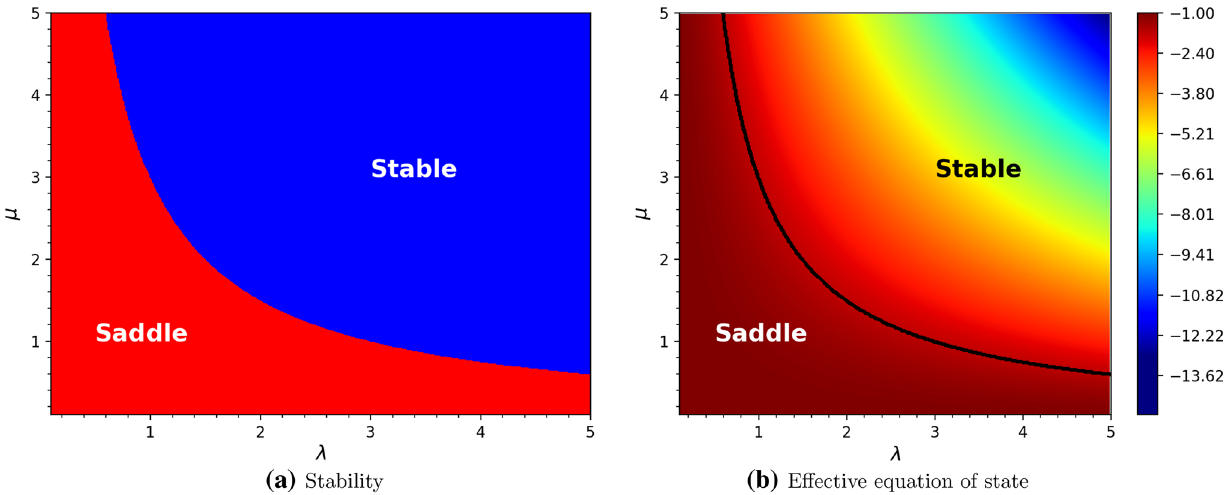
Fig. 4 On the left panel, the graph a shows the stability of the F ( B ) critical point. The saddle critical points lie in the red shaded region while blue shaded region, λ > 3 /μ , is the region where critical points